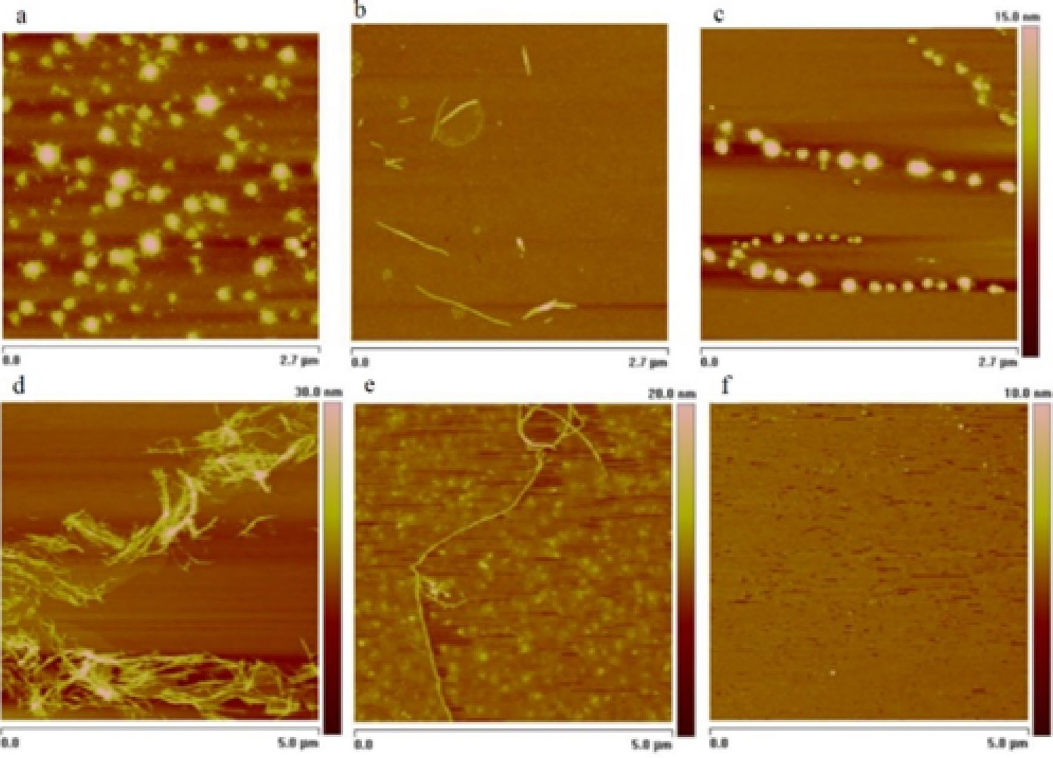
Figure 3. Atomic force microscopy images of pramlintide after 24 h incubation ( a ) without metal ions; ( b ) with Zn(II) ions; ( c ) with Cu(II) ions and after 7 days incubation ( d ) without metal ions; ( e ) with Zn(II) ions; ( f ) with Cu(II)